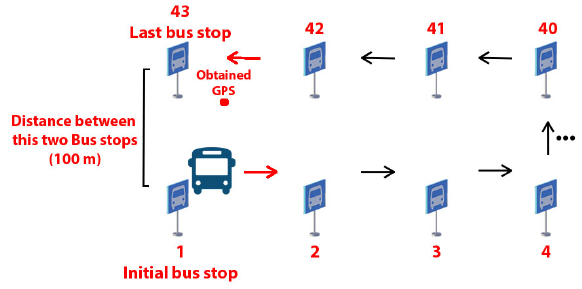
Figure 5. Sensor GPS accuracy error.